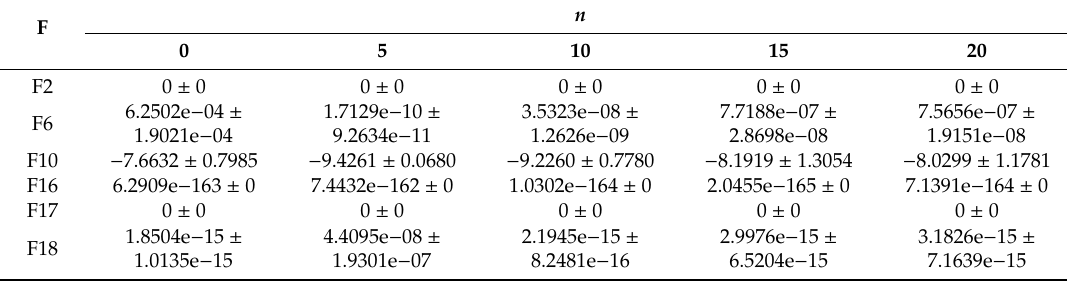
Table 2. The experimental results of ISSA with di ff erent n